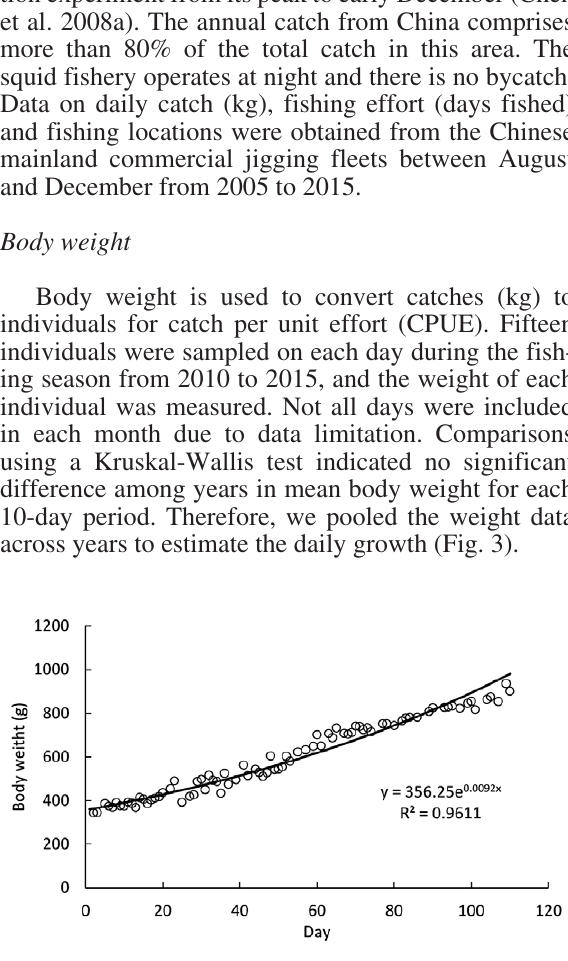
Fig. 3. – Growth curve of the western winter-spring stock of Om- mastrephes bartramii during the fishing season (from August to November in this study). Note: “Day” refers to each day during the fishing